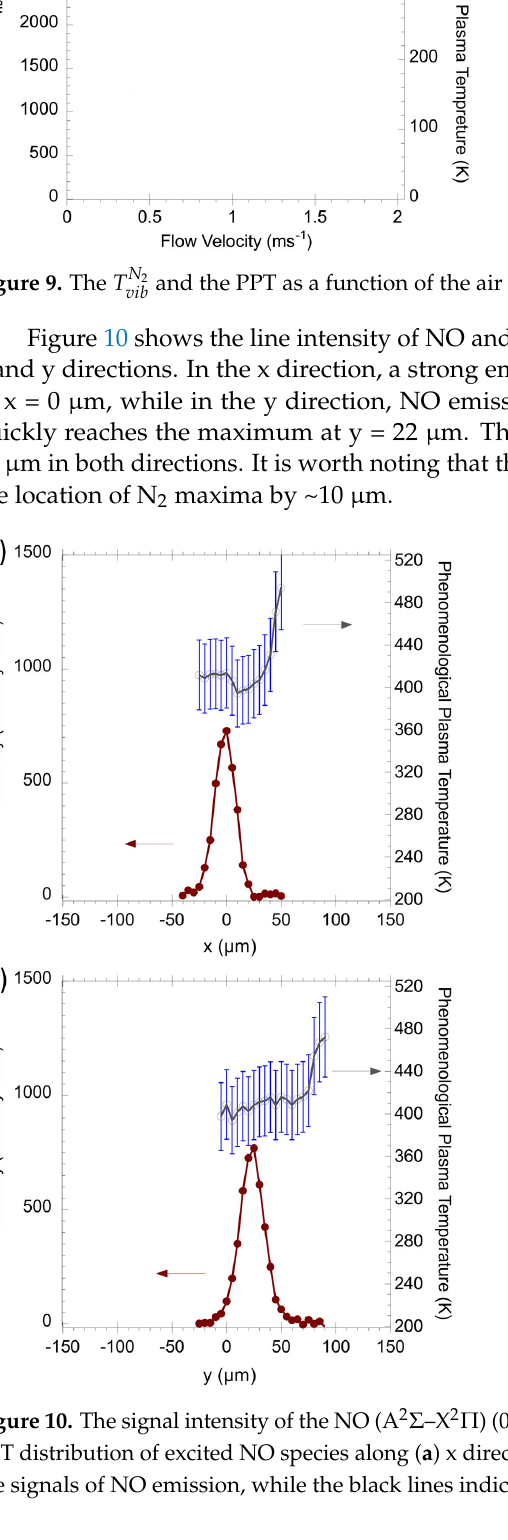
cate the signals of NO emission, while the black lines indicate the PPT distributions of NO.